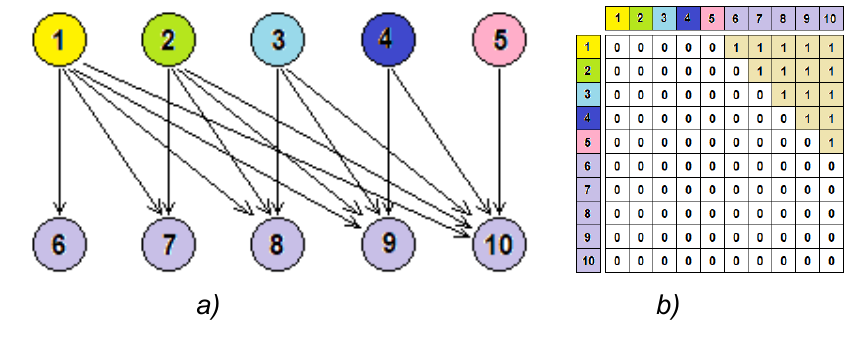
Figure 6 – The bipartite graph of FRATs/FLATs groups (a) and its adjacency matrix (b) Рис . 6 – Двудольный граф ( биграф ) фронтально / флангово - атакующих мишеней ( а ) и их матрица связи ( б ) Слика 6 – Бипартитан граф група фронталних и бочних мета за гађање ( а ) и његова матрица повезаности ( б ) For the bipartite graph G =(V(G ), E(G )) and the vertex (x , x , x , 2 2 2 1 2 3 , x ) ∈ V(G ), the out-degree of any vertex from the set (x , x , x , x , x ) x 4 5 2 1 2 3 4 5 refers to the number of edges-arrows directed away from the selected vertex. The in-degree of (x , x , x , x , x ) ∈ V(G ) refers to the number of 6 7 8 9 10 2 , x , x , x , x edges-arrows directed towards the vertex from the set (x 6 7 8 9 10